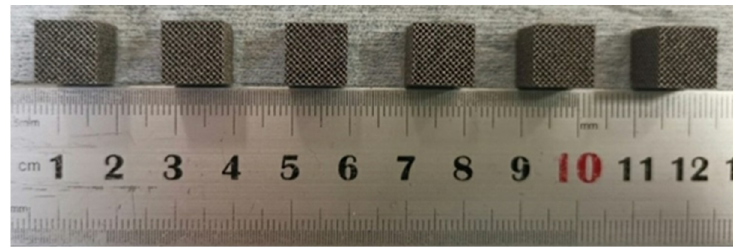
Figure 6. SLM-formed porous Ti6Al4V alloy compression test specimen.